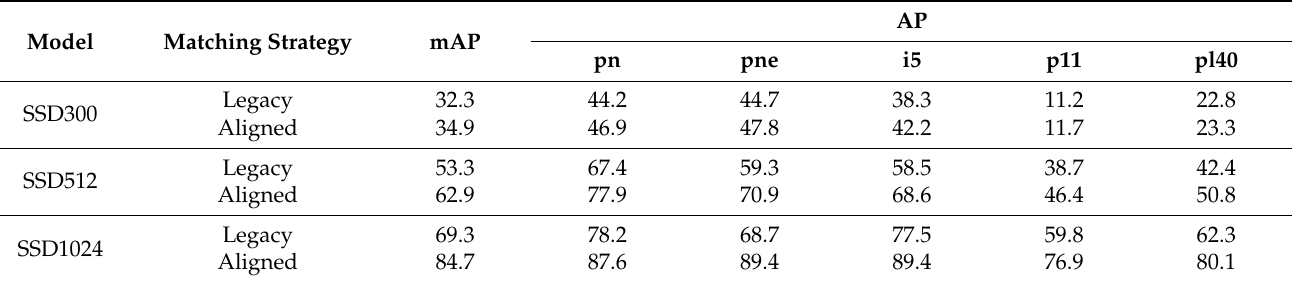
Table 2. SSD’s performance on